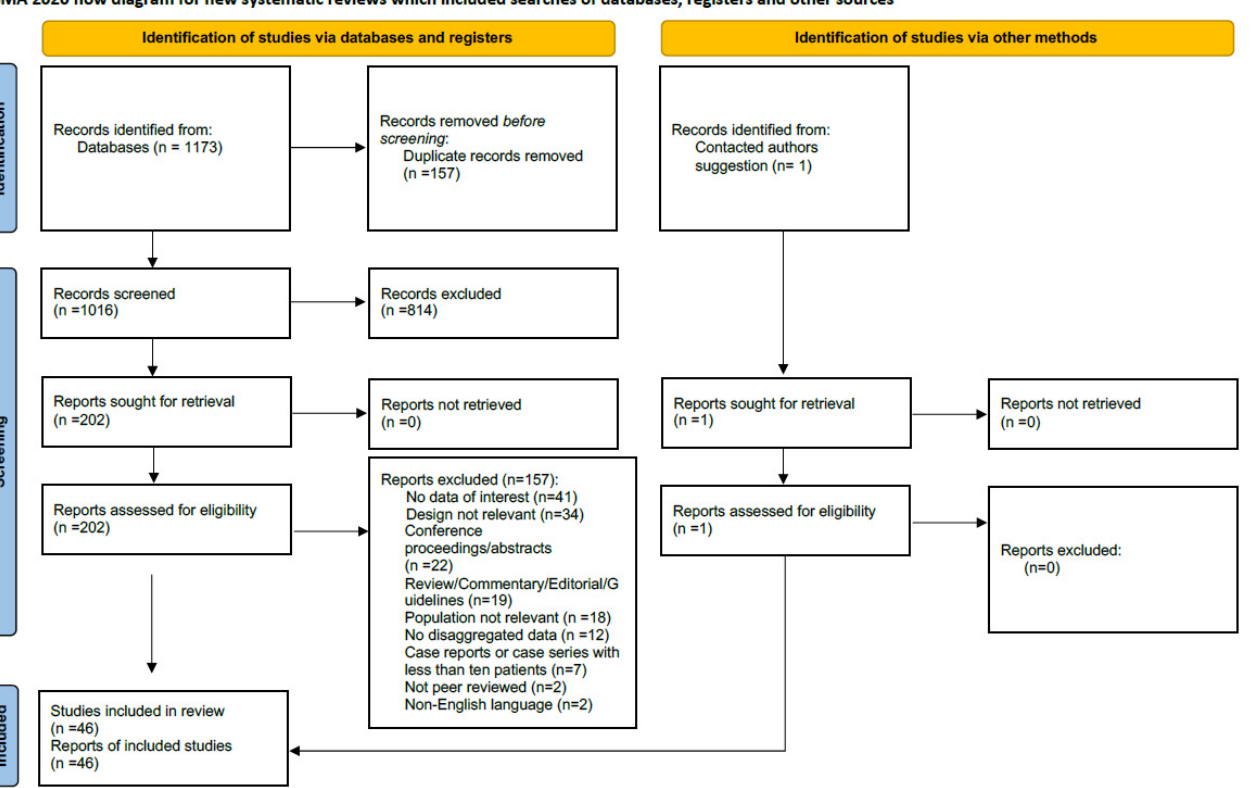
Figure 1. PRISMA 2020 flow diagram.